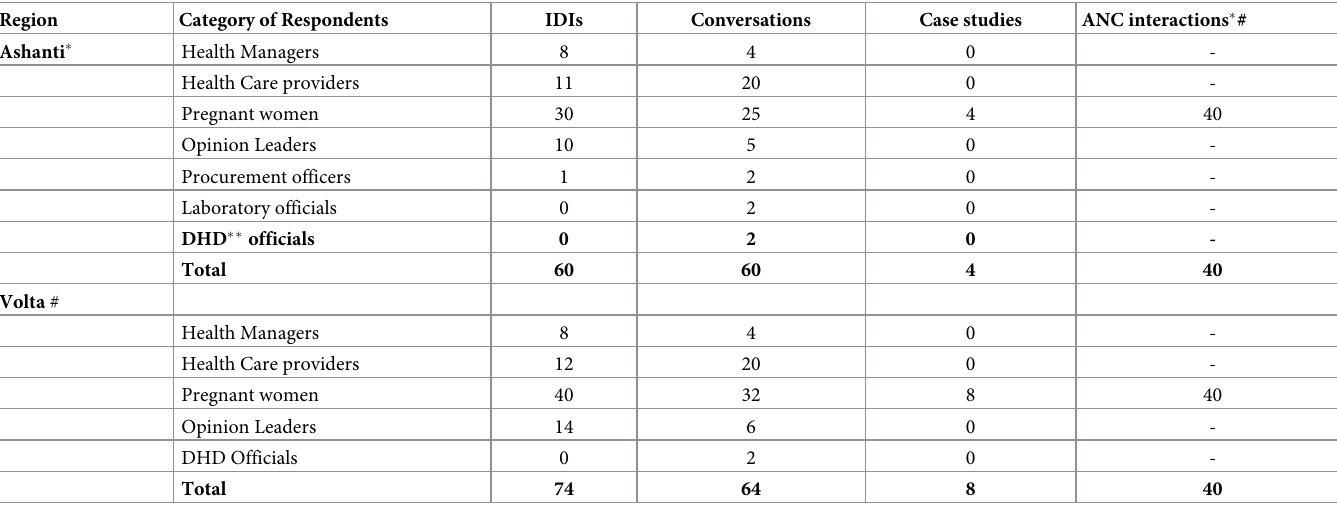
Table 2. Data collection methods and categories of